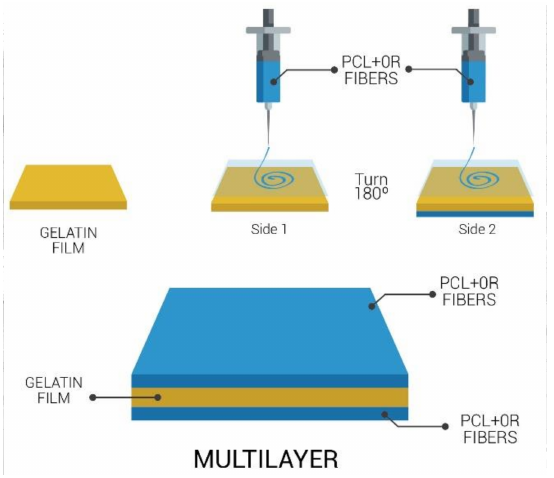
Figure 1. Scheme of the multilayer system